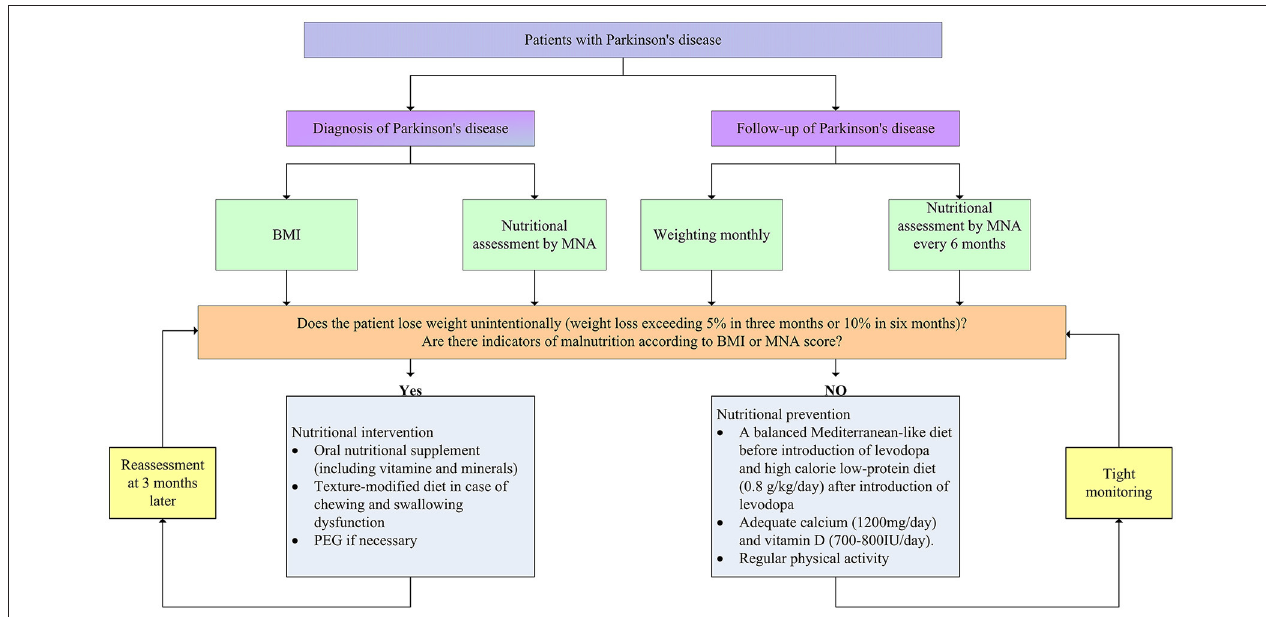
FIGURE 2 | Nutritional assessment and management in patients with Parkinson’s disease. BMI, body mass index; MNA, Mini-Nutritional Assessment; PEG, percutaneous endoscopic